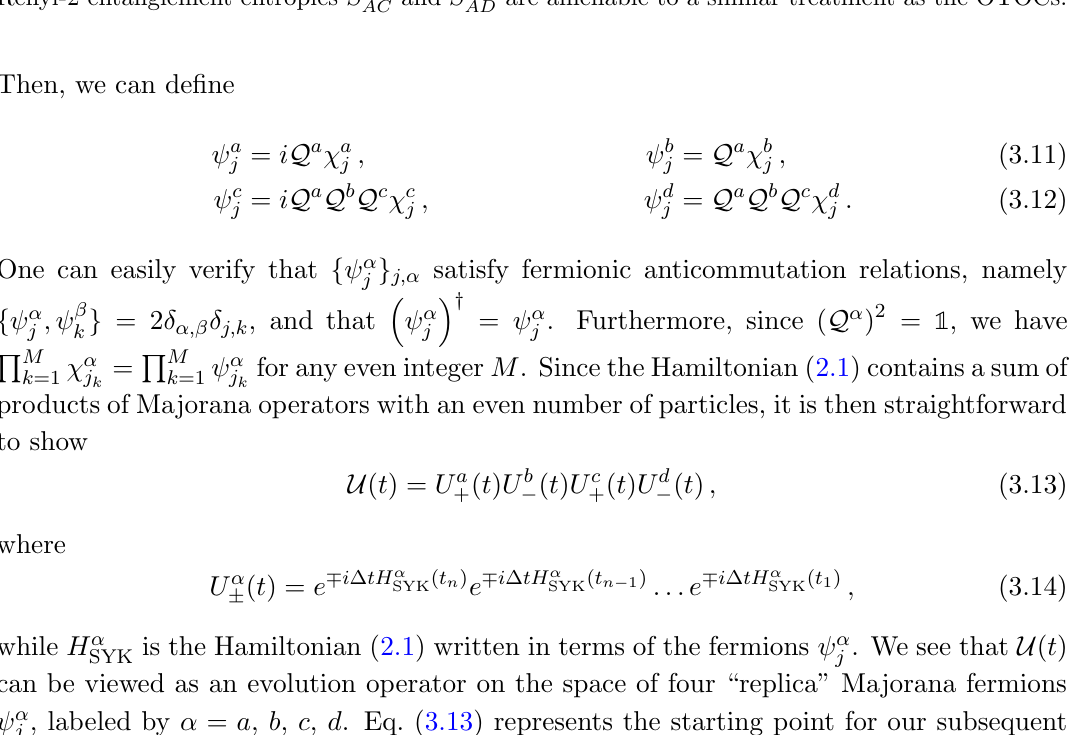
( t ) U U (cid:3) U U (cid:3) ( t ), while the observables U (cid:17) (cid:10) (cid:10) (cid:10) L , R (cf. section 3.1). Exploiting the emergent permutational j i j i U (cid:3) U U (cid:3) ( t ) onto a state ( t ) in a bosonic Fock space, in which (cid:10) (cid:10) (cid:10) jU ii